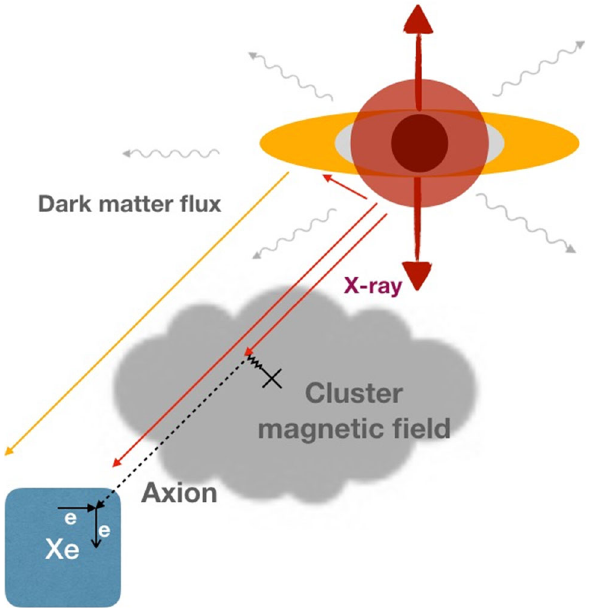
Fig. 1 The schematic diagram of axion flux converted from the X-rays passing through the cluster of magnetic field